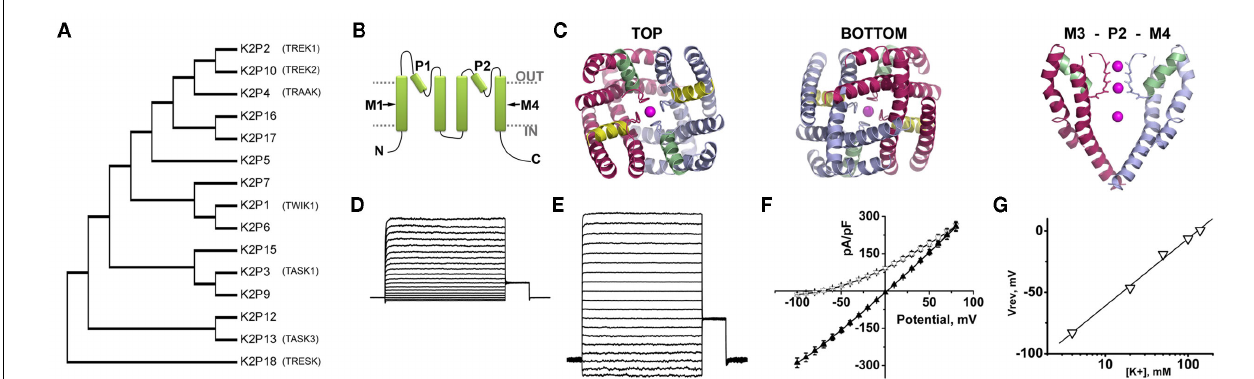
by K + is denoted in each case. From above or below, the model shows twofold symmetry, with conservation of the fourfold symmetry required to form a K + selective pore. Adapted from Kollewe et al. (2009). (D) A K + leak current recorded from a Chinese Hamster Ovary cell transfected to express active human K2P1 channels.The inside of the cell is perfused with 140mM K + and the outside of the cell is perfused with 4mM K + . (E) The same cell recorded in (D) with 140mM K + on the inside and the outside of the cell. (F) The current–voltage relationships for the cell (cid:2) recorded in (D) (cid:2) , and (E) ( ). (G) The same cell recorded in (D) studied in various concentrations of external K + .The voltage where zero-current was passed for each condition is plotted against the log 10 of the external K + concentration.The data are fit to a linear regression and show a shift of ∼ 54mV per 10-fold change in K + .This relationship is predicted by the Nernst equation and confirms the K + selective nature of the channel (see also Figure 1A ). Elements D to F are adapted from Plant et al.